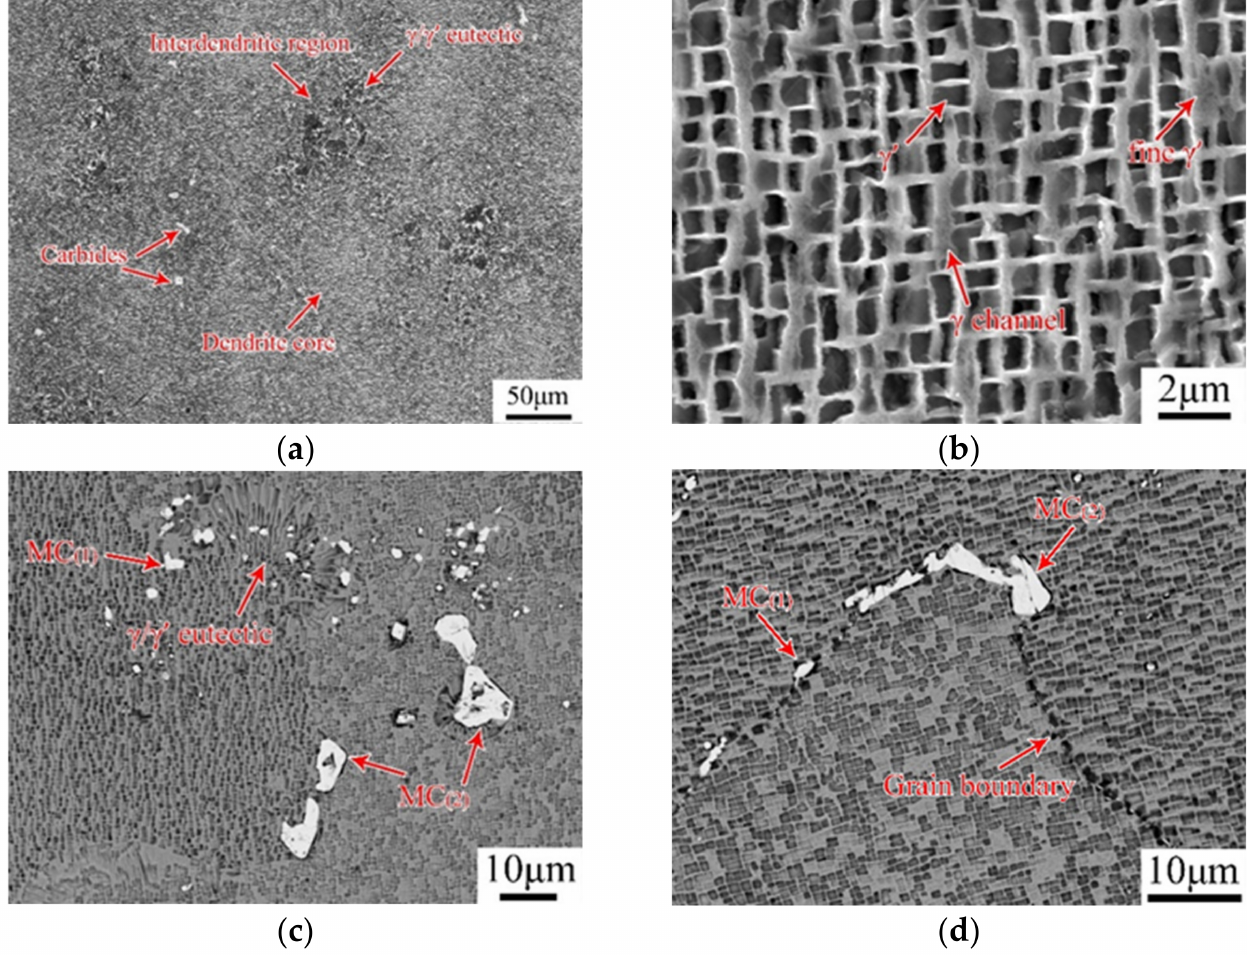
Figure 1. As-received microstructure of DZ406 superalloy at the cross sections after the standard solution treatment: ( a ) optical microstructure; ( b ) SEM-SE image of γ (cid:48) precipitates in the dendrite core region; ( c ) SEM-BSE image of interdendritic carbides; ( d ) SEM-BSE image of grain